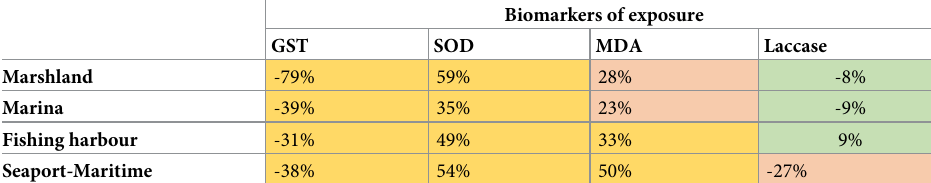
Table 1. Reliability or difference between “inter-subject” (n = 7) and “pool” studies at each site (marshland, marina, fishing harbour and seaport-Maritime) at D21 for the 4 biomarkers of exposure (GST, SOD, MDA and Laccase). Green shading represents 0–20% difference, red shading represents 20–30% difference and yellow shading represents more 30% difference. Negative percentages are lower rates in the “inter-subject” study compared to the “pool” analysis.